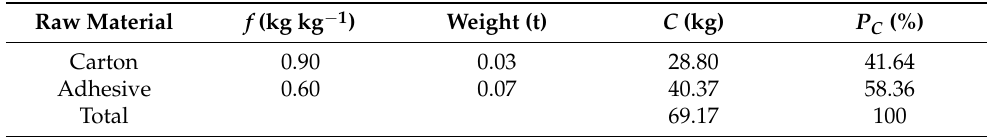
Table 3. CO 2 emissions for the raw materials in producing 1 t of FBCBs.